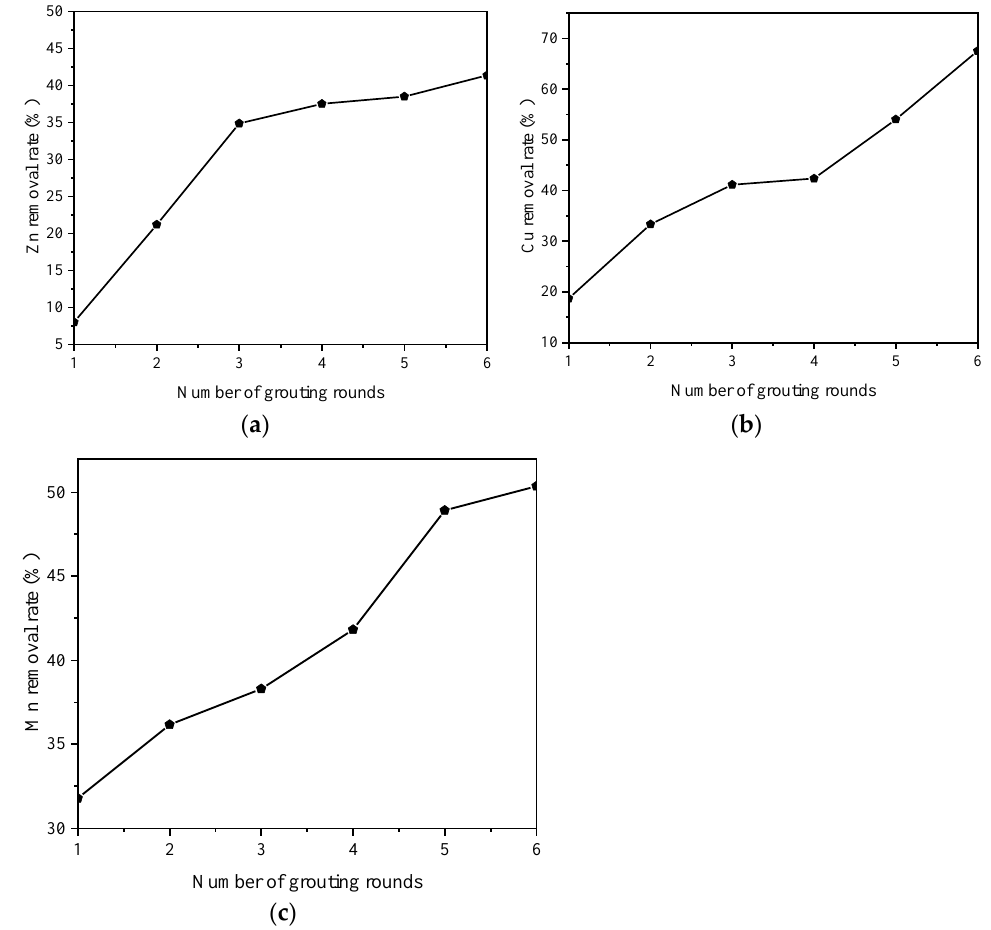
Figure 6. Changes in the removal rate of common heavy metals from samples with 1 – 6 rounds of grouting: ( a ) result for Zn; ( b ) result for Cu; ( c ) result for Mn.